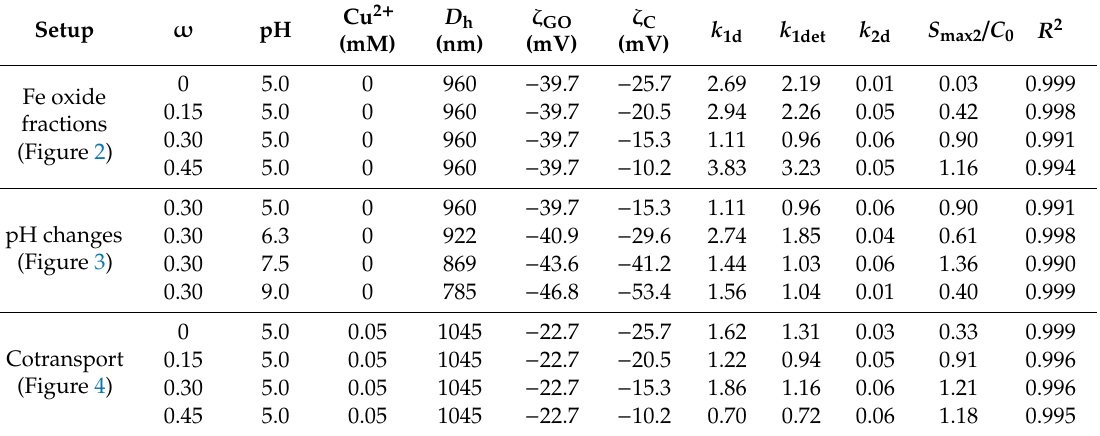
Summarized experimental setups, properties of GO and quartz sand, and fitted model